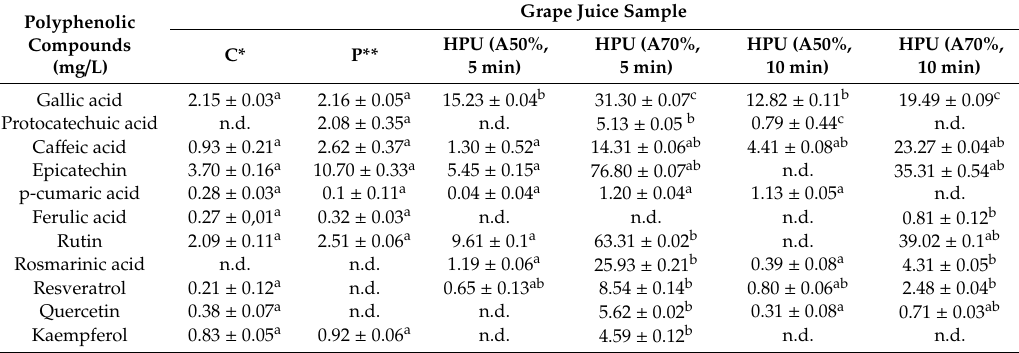
Table 3. E ff ect of pasteurization and HPU treatments on the polyphenolic compounds profile of grape juice